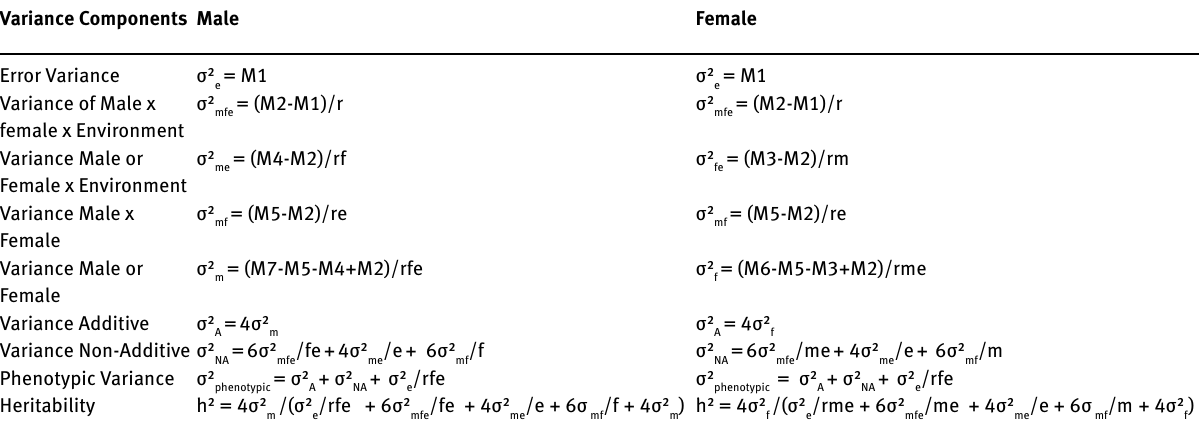
Table 3: Estimates of Variance Components in Mating Design II over environments for model II for male and female components Variance Components Male Error Variance Variance of Male